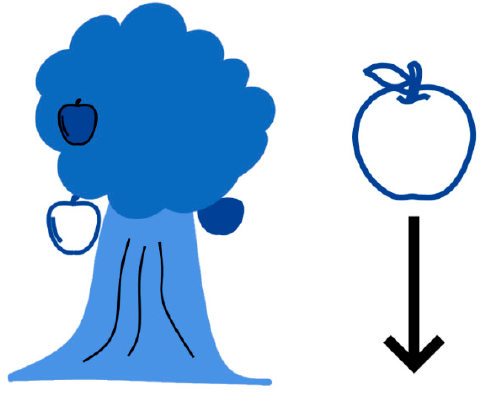
Figure 3. A falling apple.